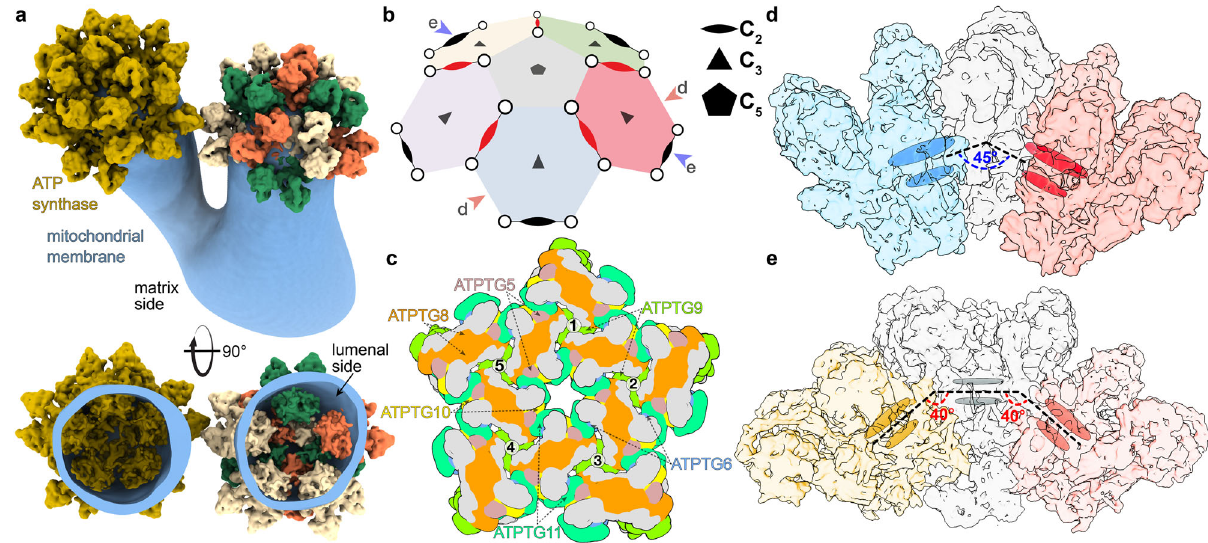
Fig. 6 T. gondii ATP synthase arranges into pentagonal pyramids with icosahedral symmetry to induce membrane curvature. a Cryo-ET of the mitochondrial membranes (blue) and subtomogram averaging of dimers reveals their macromolecular arrangement into pentagonal pyramids held together by proteins in the lumen. b Schematic representation shows fi ve hexamers (coloured) arranged around a C 5 -axis. Red and blue arrows indicate cross-sections shown in the other panels. Inner and outer dimers are shown as red and black ellipses, respectively. c Schematic of interactions between luminal subunits involved in the assembly of the pentagonal pyramid. d Neighbouring hexamer planes (blue and red) are arranged at a ~45°-angle around the shared dimer (grey). e Cross section through the pentagonal ATP synthase pyramid showing two 40°-angles between hexamer (yellow, red) and pentamer (grey)